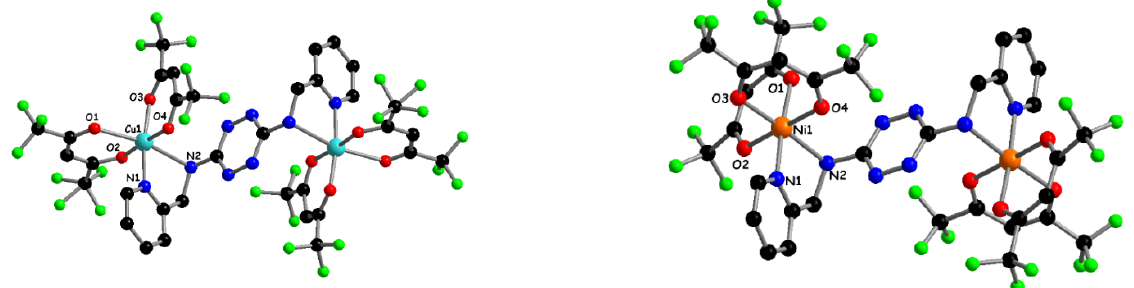
Figure 3. Crystal structures of 3 ( left ) and 4 ( right ) together with a partial atom numbering scheme. Hydrogen atoms and solvent molecules were omitted for clarity.